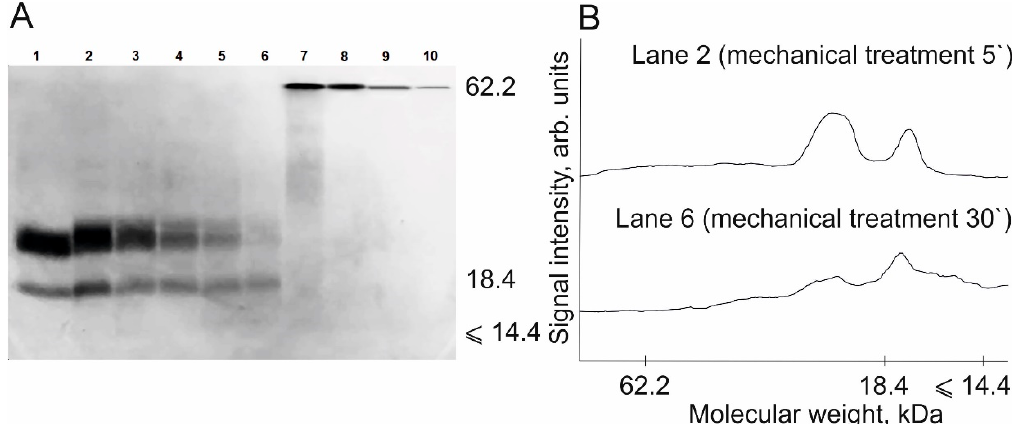
Figure 7. ( А ) Electropherogram of the initial sample of milk protein isolate (lane 1) and the samples of milk protein after mechanical treatment for 30, 20, 15, 10, and 5 min, respectively (lanes 2–6), as well as the calibration BSA samples with concentration ranging from 0.125 to 2.0 mg/mL (lanes 7–10). ( B ) Densitograms of BSA degradation products after mechanical treatment for 5 and 30 min (lanes 2 and 6).